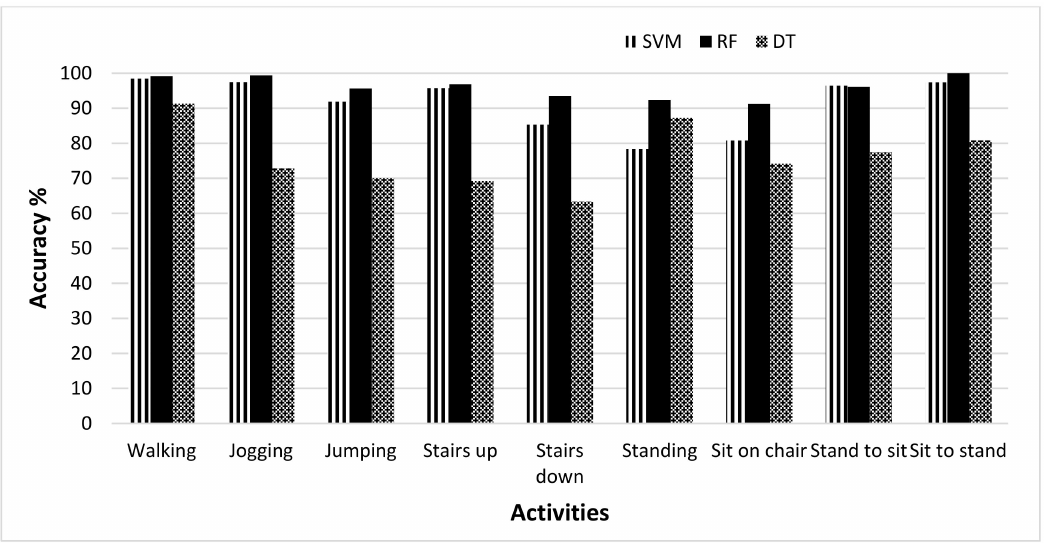
Figure 4. User recognition accuracy of RF, SVM, and DT classifiers for selected activities in MobiAct dataset.